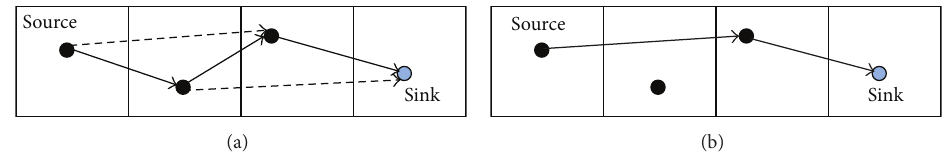
Figure 4: Comparison of the routing scheme between GAF and T-GAF (a) In GAF, a sensor can forward the data packet to any sensors of its AGs, while (b) In T-GAF, a sensor can forward the data packet to any sensors of its NAGs, if they are in the transmission range.